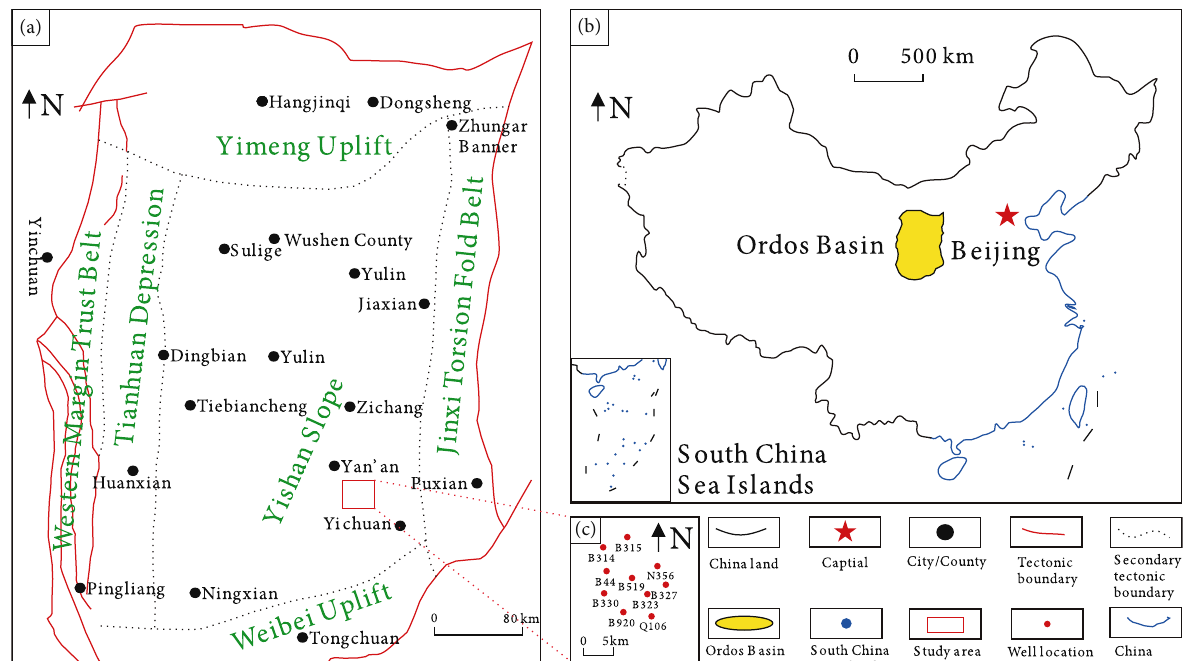
Figure 1: Location of the study area and sampling points in the Ordos Basin (modi fi ed from